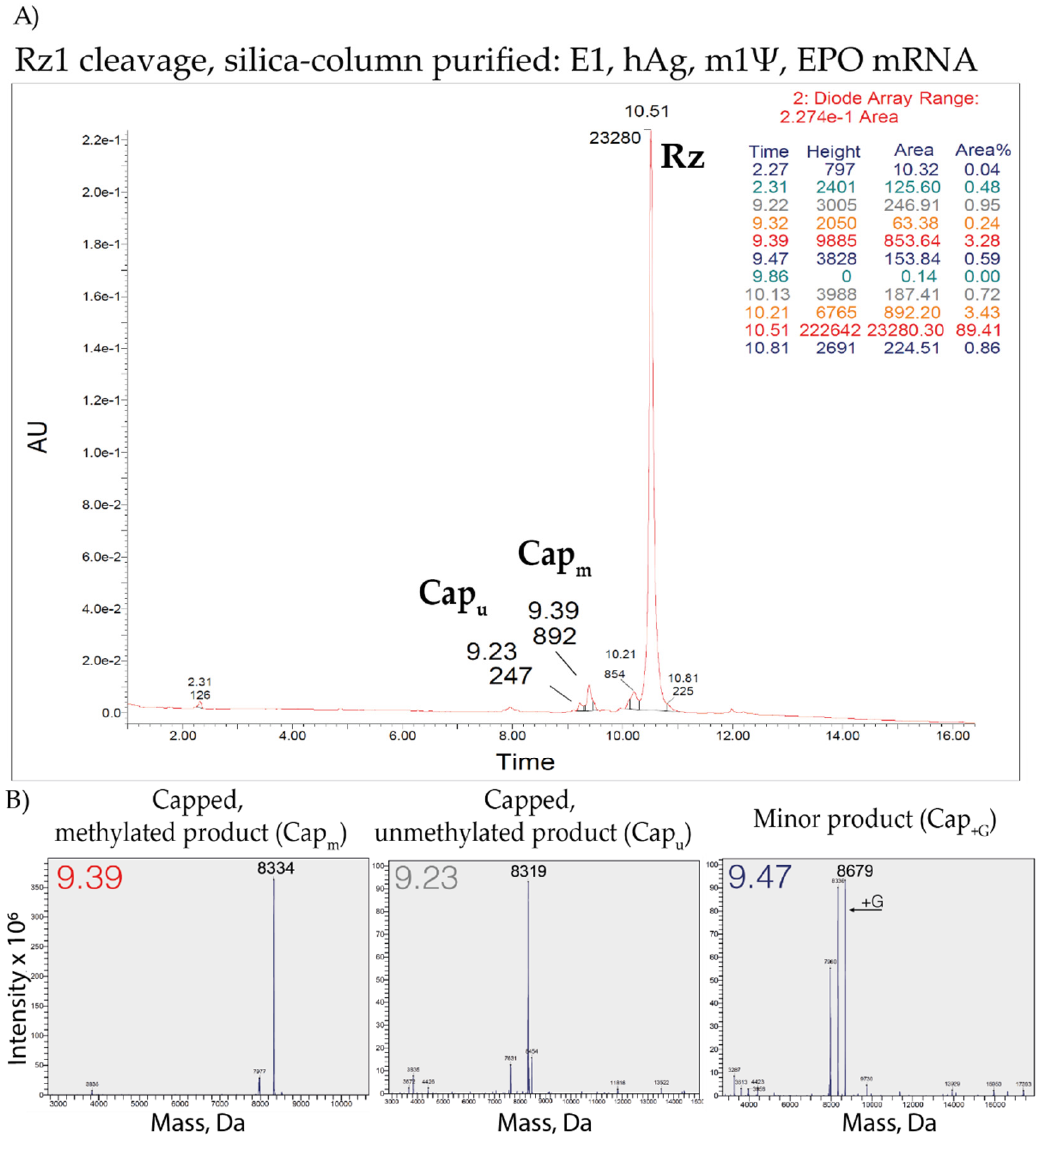
Figure 7. LC–MS analysis of ribozyme-mediated cleavage products for quantification and characterization of capped products from Rz1 cleaved and silica-column purified enzymatically capped and 2 ′ -O-methylated (E1), human alpha globin (hAg), m1 Ψ -containing erythropoietin (EPO) mRNA. The enzymatical capping procedure provides 7MeGpppA(OMe)GGCGAACU*AGU*AU*U*-CU*U*CU*GGU*Cp (MW = 8334) and 7MeGpppAGGCGAACU*AGU*AU*U*CU*U*CU*GGU*Cp (MW = 8319) in a 7:2 ratio, resulting from an incomplete 2´O-methyl transfer. ( A ) UPLC and ( B ) MS profiles. Rz: Ribozyme; Cap: Capped product; Cap m : Capped methylated product; Cap u : Capped unmethylated product; Cap +G : Minor product; AU: Arbitrary units.